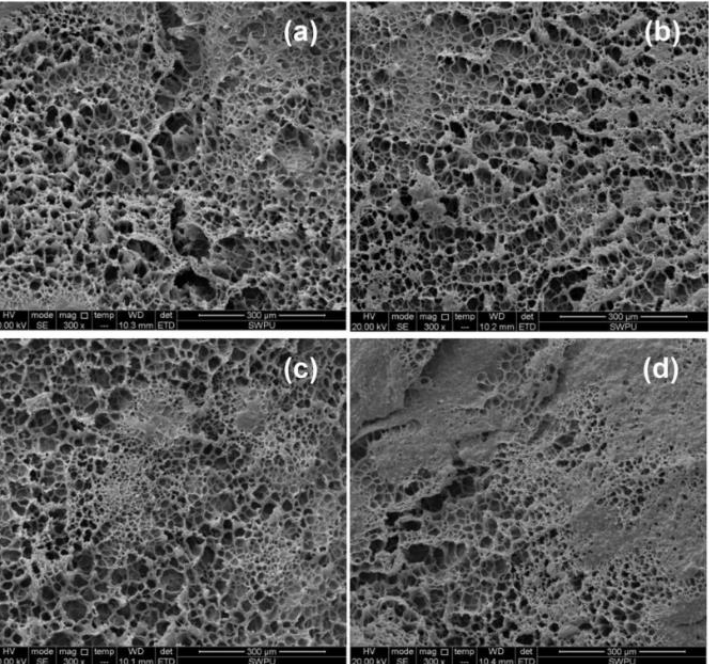
Figure 9. Microstructure of the polymer gel with the addition of different concentrations of SiO 2 . ( a ) 0% nano-silica; ( b ) 1% nano-silica; ( c ) 3% nano-silica; ( d ) 5% nano-silica. (Reprinted/adapted with permission from Ref. [62]. 2020, Jia, et